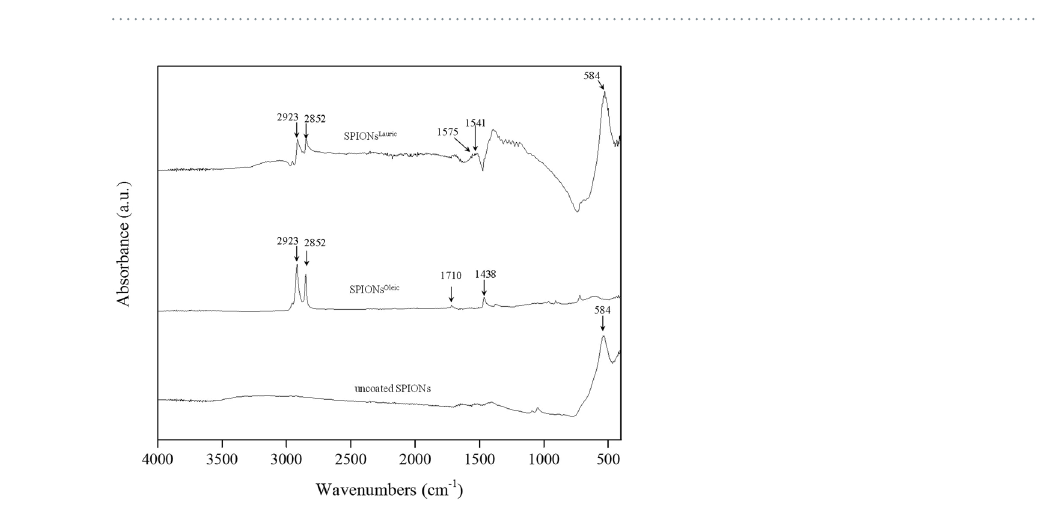
Figure 1. Surface morphology of ( a ) PHBV and ( b ) PHBV containing SPIONs Oleic .